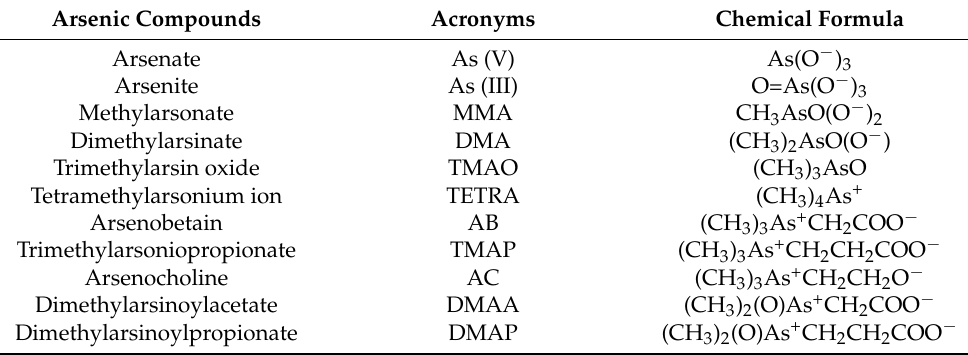
Table 1. The list of various species of